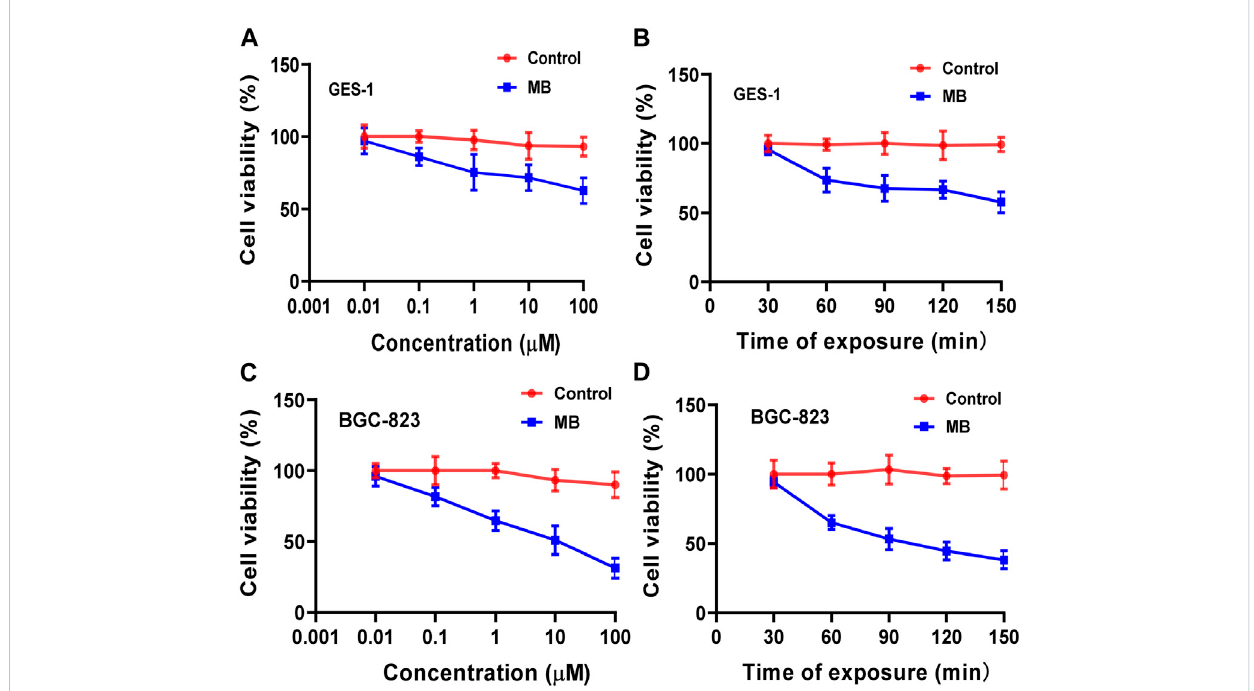
FIGURE 2 CellviabilityofNIR fl uorophoresMBinhumangastricepithelialGES-1cellsandhumangastriccancerBGC-823cells. (A,C) GES-1andBGC-823cells were incubated with MB with different concentrations for 60 min, and cell viability was determined compared to a control sample (human gastric epithelial and gastric cancer cells without MB). (B,D) Cell viability was also observed with MB (1 µM) at various NIR irradiation exposure